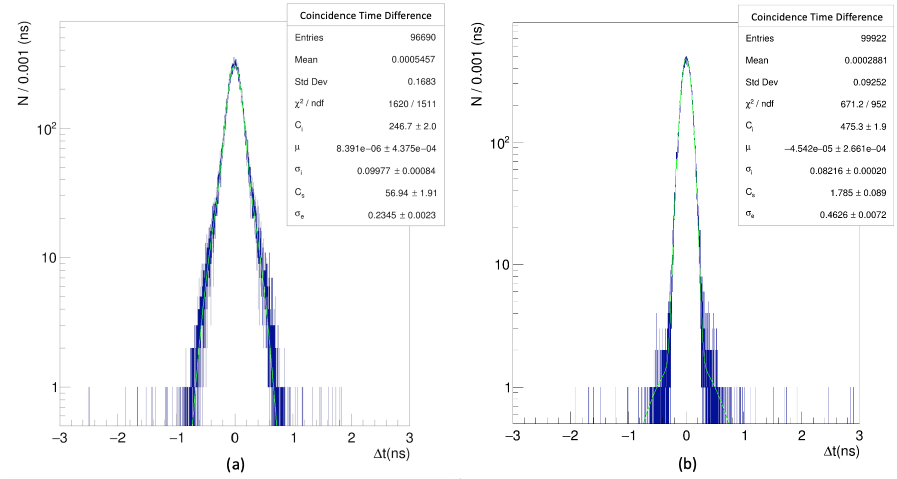
Figure 8. Distributions of time difference between left and right SiPMs ( ∆ t = t left − t right ) for ( a ) 20 mV low and ( b ) 70 mV high thresholds for the Eljen-228 scintillator. Each distribution is fitted by the superimposition of two Gaussians with the same mean. The CTR represents the core standard deviation of the Gaussian function ( σ ∆ t ) and reveals ( 100 ± 0.8 ) ps and ( 82 ± 0.2 ) ps, respectively.